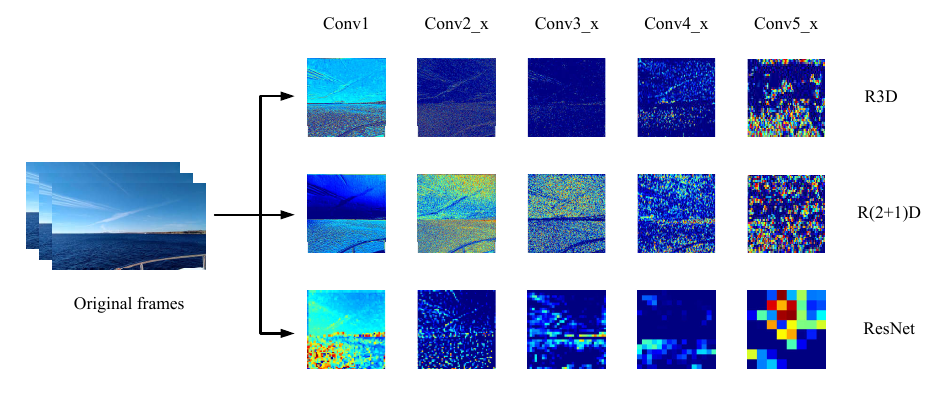
Figure 2. Feature maps generated by convolutional networks with different